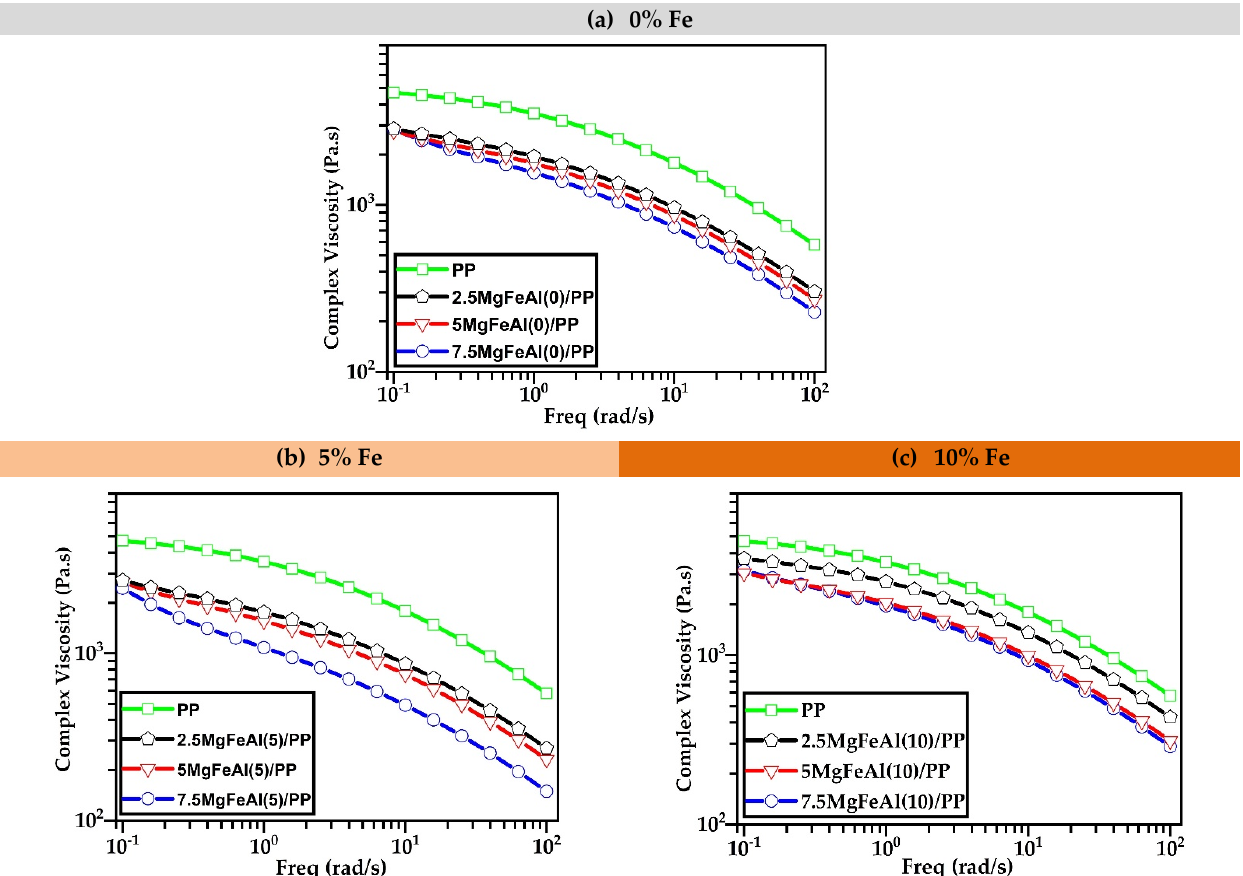
◦ C: ( a ) 0, ( b ) 5, and ( c ) 10%